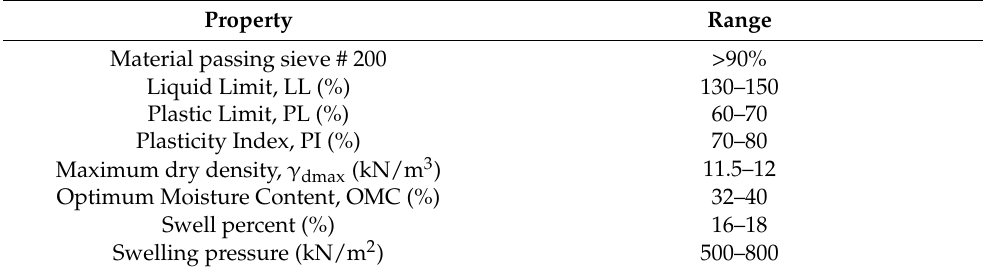
Table 1. Physical properties of the clay used in this study (after [25]).